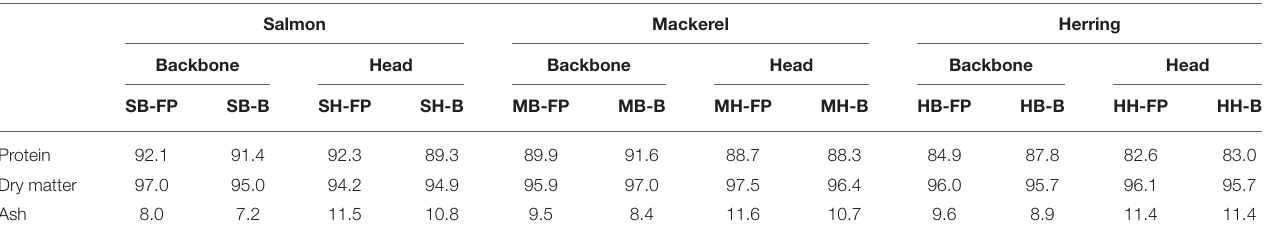
TABLE 4 | Amino acid composition (g/100g sample) a of protein hydrolysates based on salmon (S), mackerel (M) and herring (H) backbones (B) and heads (H), using enzymes Food Pro (-FP) and Bromelain (-B). Salmon Mackerel Herring Backbone Head Backbone Head Backbone Head SB-FP SB-B SH-FP SH-B MB-FP MB-B MH-FP MH-B HB-FP HB-B HH-FP HH-B IAA 2 Arginine Histidine 2.2 2.2 1.9 Isoleucine 2.5 Leucine Lysine 6.0 Methionine Phenylalanine